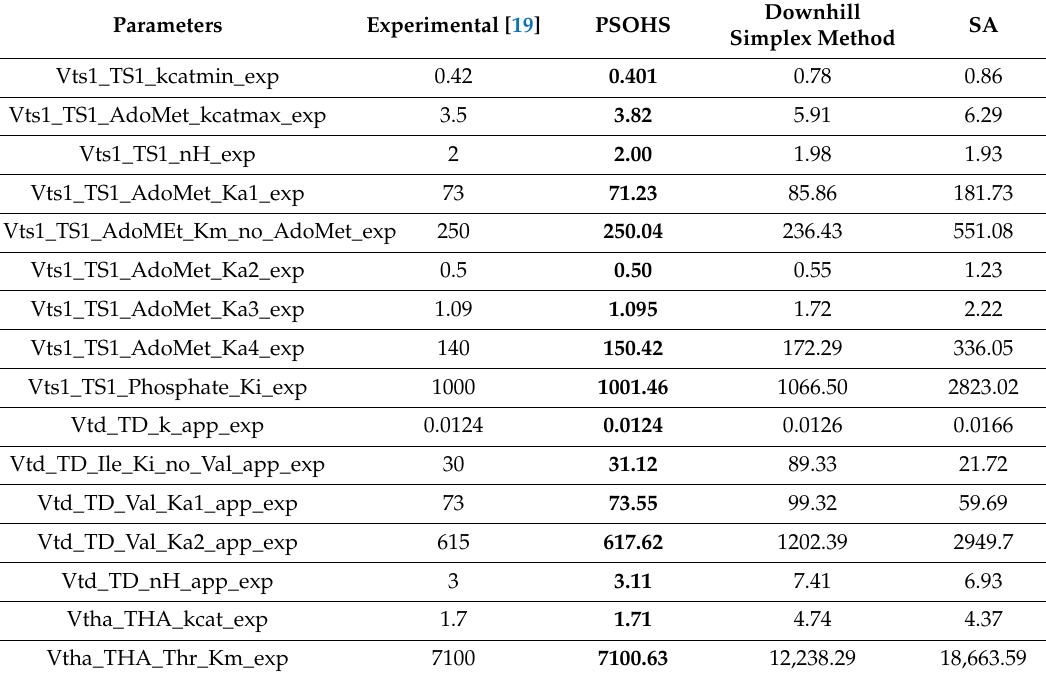
Table 7. List of kinetic parameter values for threonine with the experimental